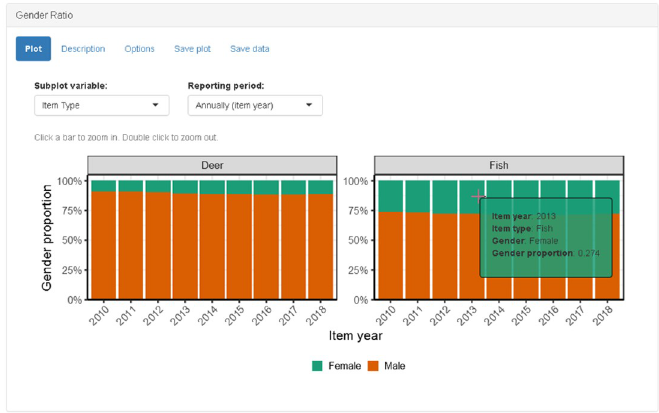
Fig 4. Screenshot of gender ratio panel when “item type” is selected as subplot variable. For simplicity, only two item types are shown; additional rows are added automatically to accommodate any number of subplots.